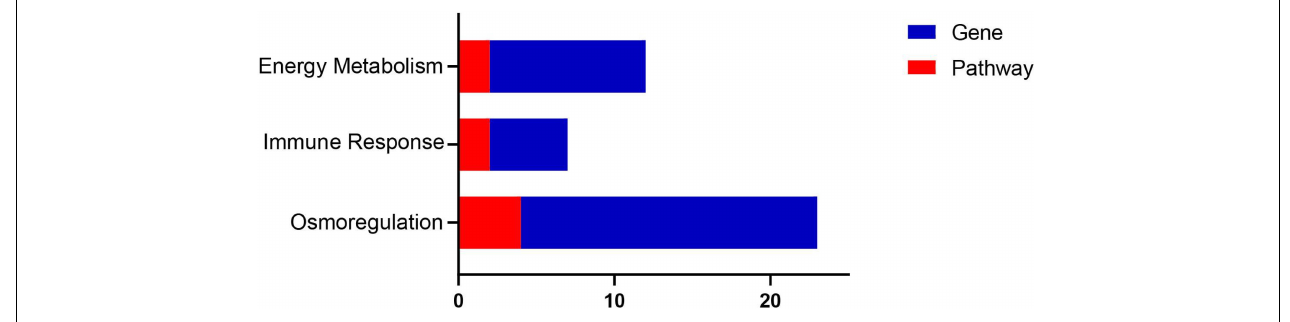
FIGURE 9 | Enriched DEGs may be related to osmotic adjustment, immunity, and energy metabolism.